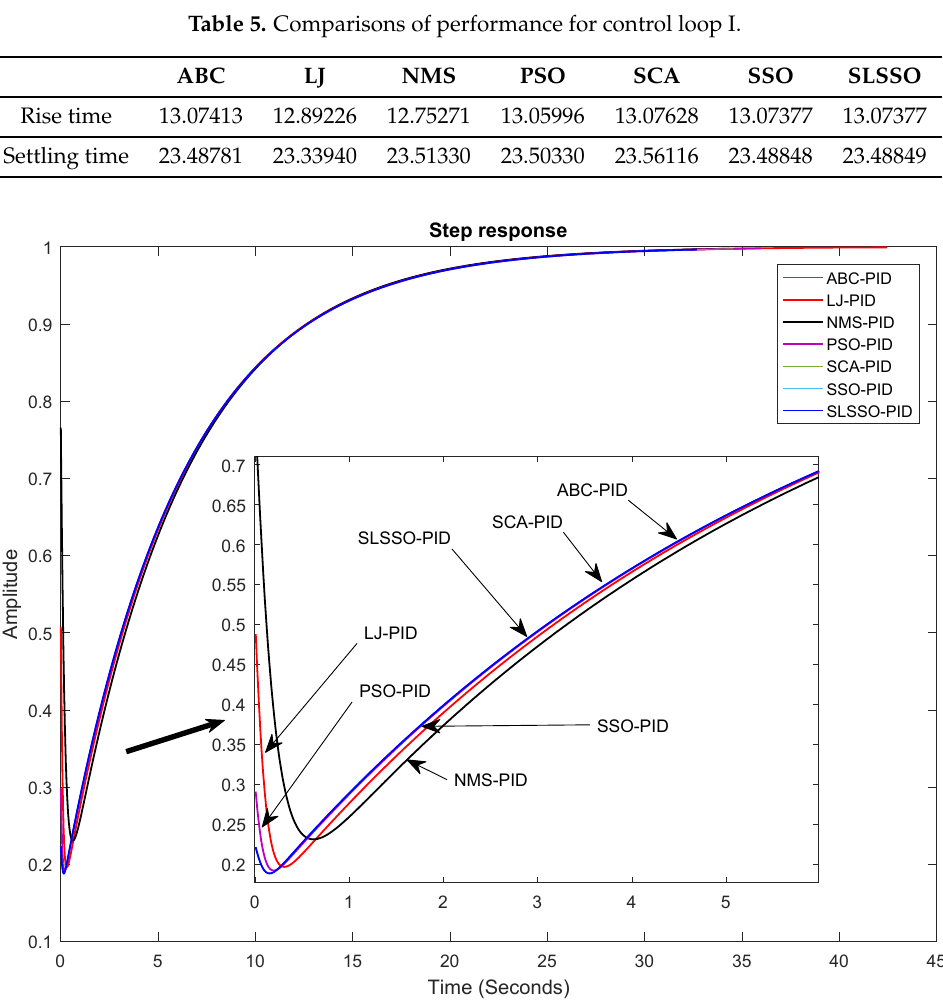
Figure 5. Unit step response for control loop